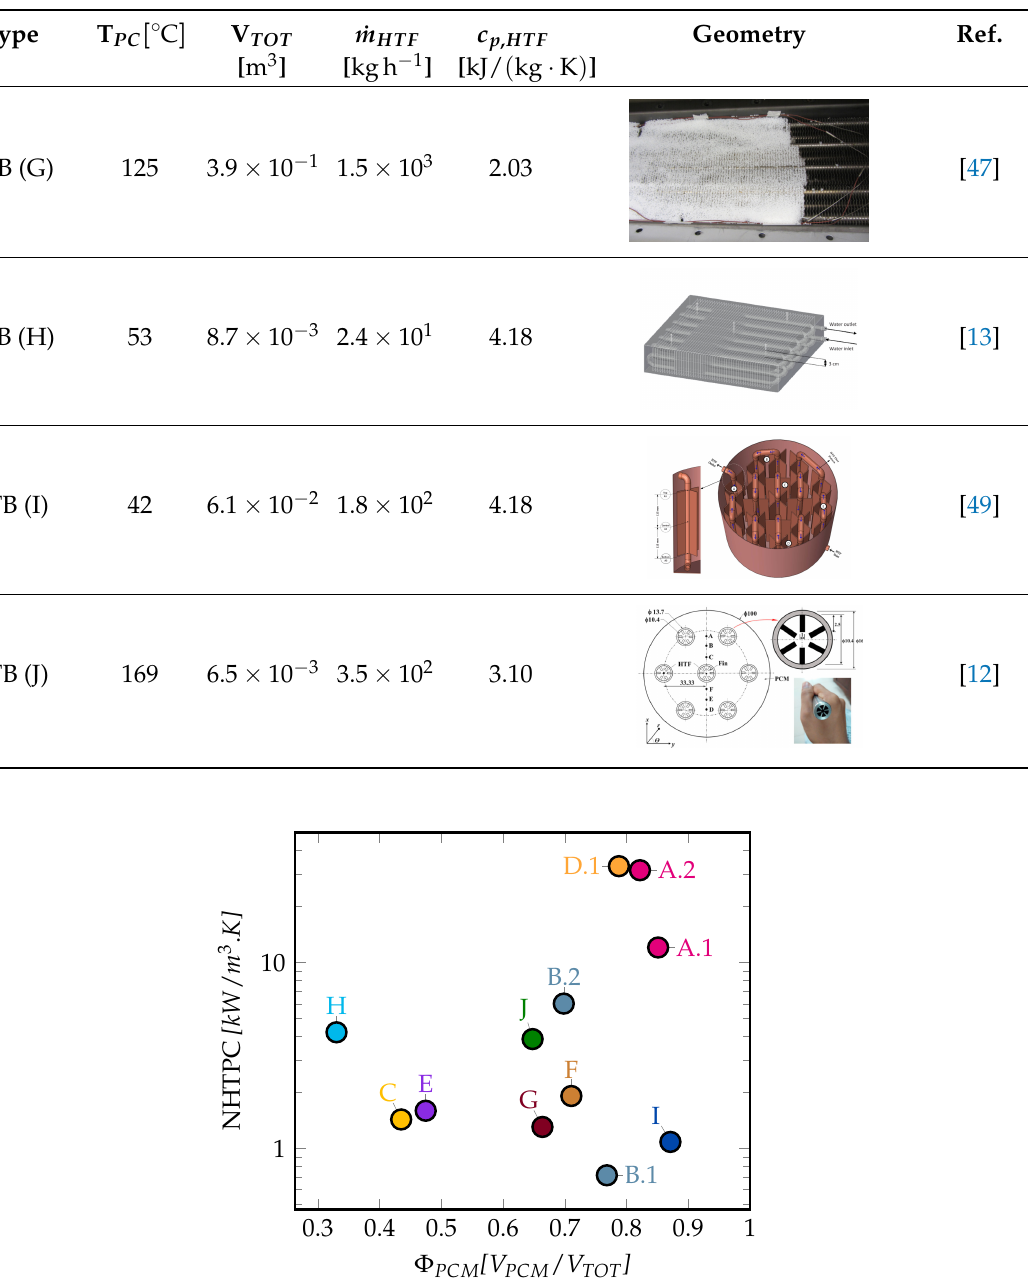
Figure 2. Calculated NHTPC vs. Φ PCM for the references concerning tube bundles (TB) and finned tube bundles (FTB) in LHES unit configurations in logarithmic